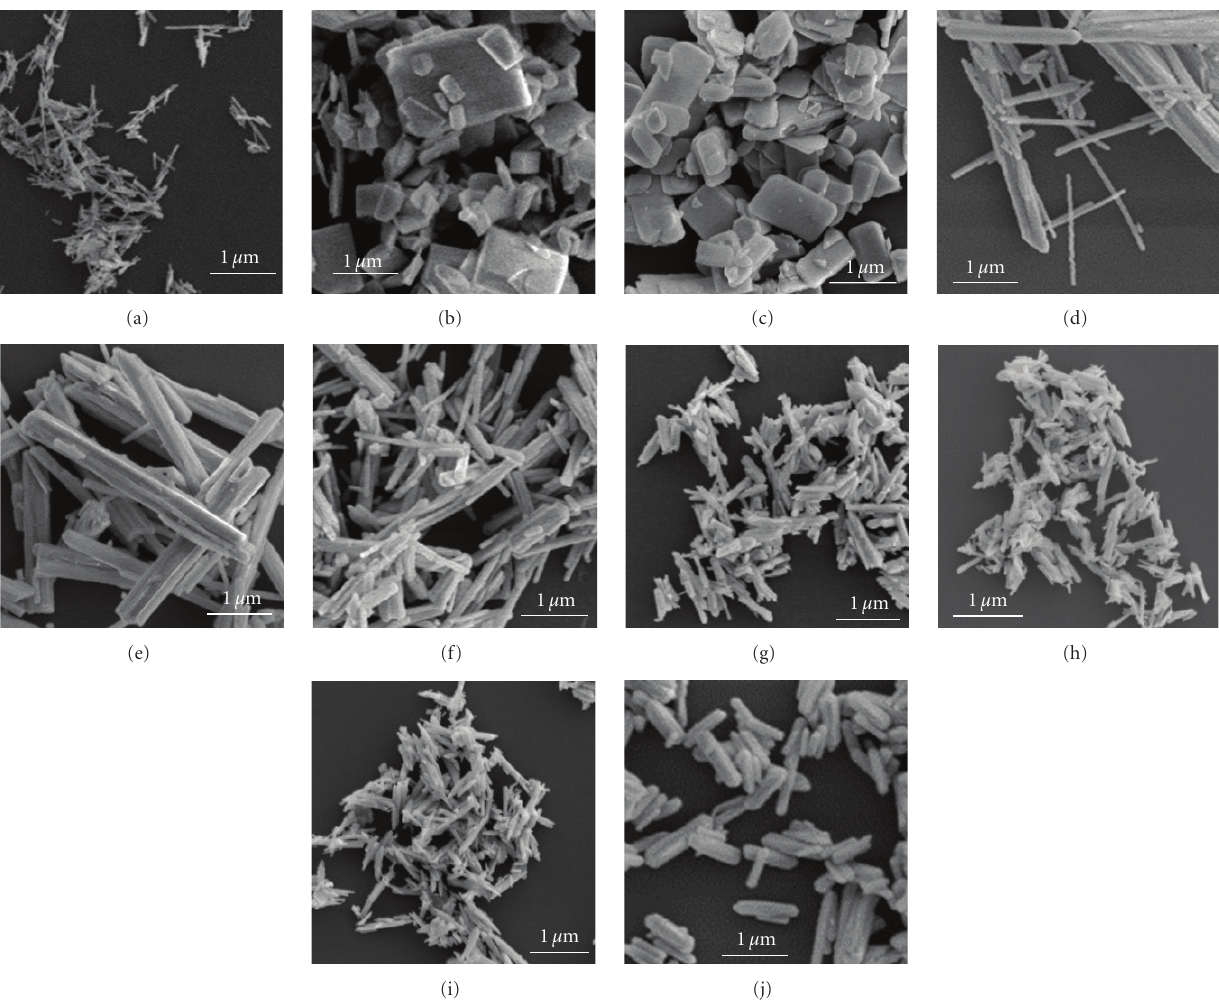
Figure 1: Scanning electron micrographs of Gd 2 O 3 :Er 3+ ,Yb 3+ nanorods by hydrothermal synthesis using various precipitation agents: (a) KOH aq . ( Rods12 ) or ammonia: (b) 0.1 mL, (c) 0.2 mL, (d) 0.35 mL, (e) 0.5mL, (f) 1.0 mL, (g) 2.0 mL, (h) 3.0 mL, (i) 5.0 mL. (j) Influence of mixing order, 1mL ammonia ( Rods5